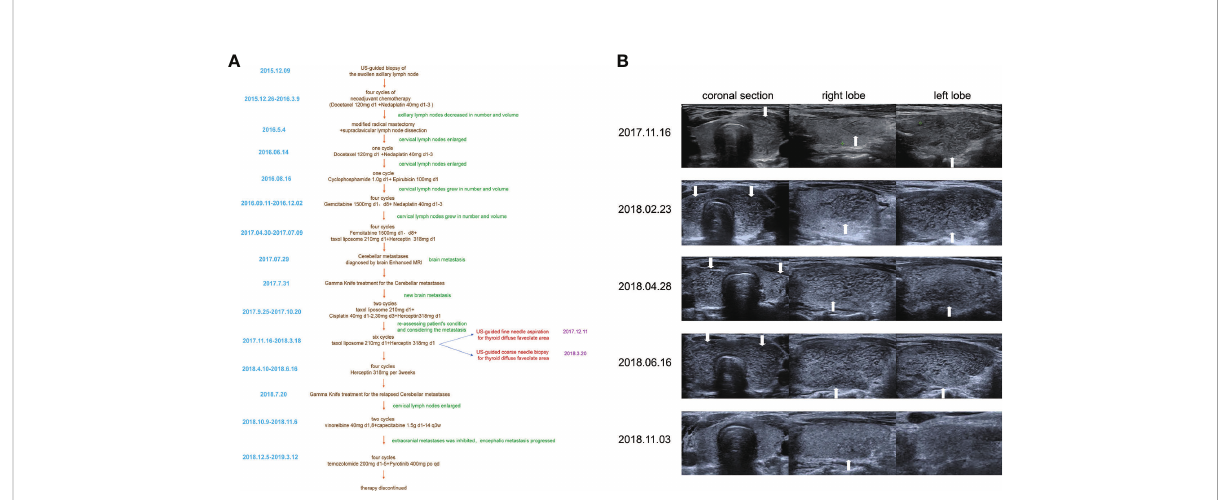
FIGURE 1 (A) The timeline of the whole management course of the patient with occult breast cancer. (B) One-year follow-up US features with thyroid metastases from her occult breast cancer (arrows show the metastasis areas which manifested as diffuse faveolate changes in the